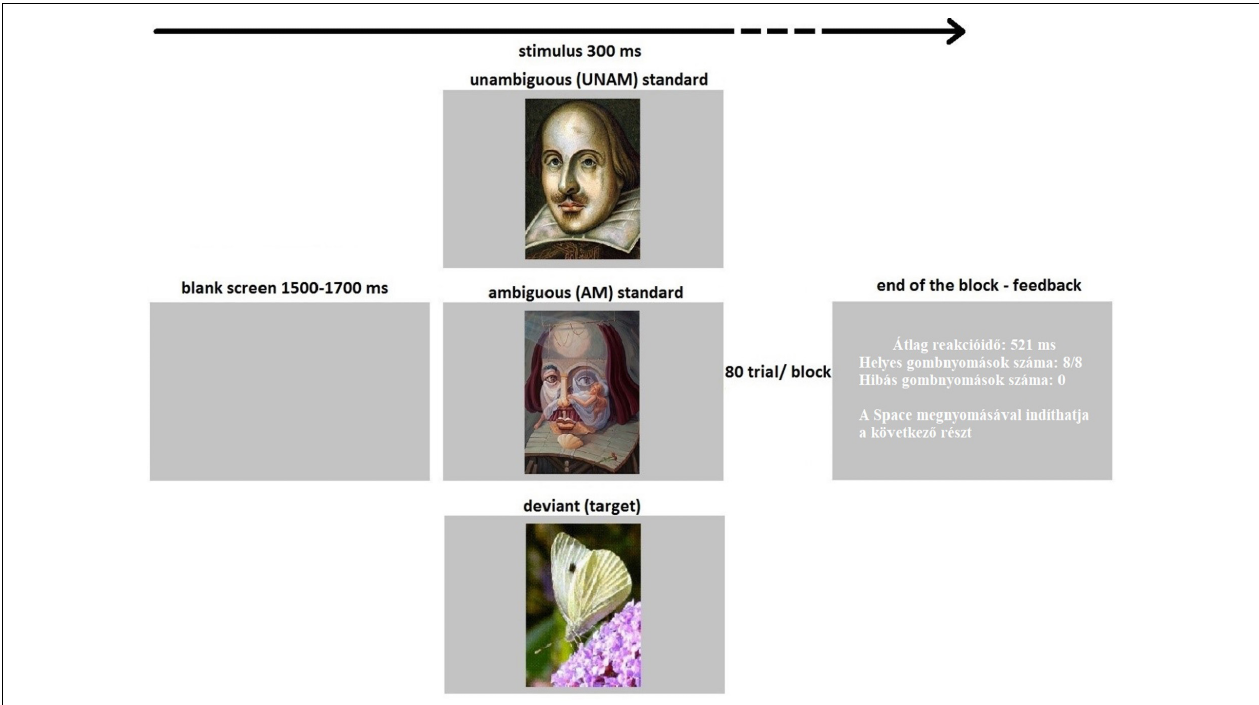
FIGURE 1 | Illustration of the sequence and timing of stimuli: The target (10%, a butterfly) which the participants had to press a button for, or a standard stimulus (45–45% unambiguous or ambiguous portraits) which no reaction was needed, was presented for 300 ms. An inter-stimulus interval with a blank screen lasted for 1500–1700 ms. Participants got feedback at the end of the block of 80 trials. The feedback contained average reaction time, number of correct and incorrect button presses and an instruction to “Press Space to start the next section”. The experiment contained six